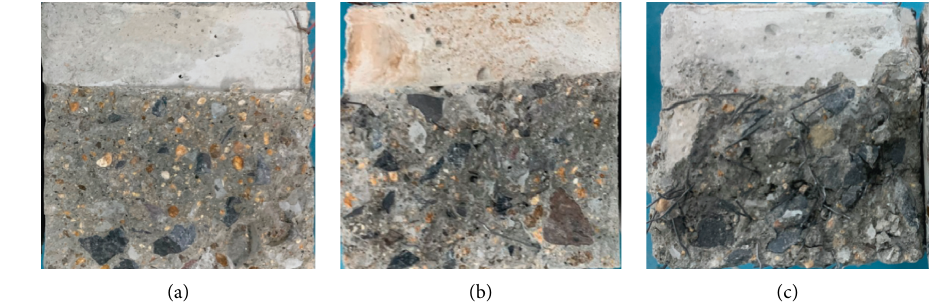
Figure 4: Fracture surface. (a) R100-1-0. (b) R100-1-0.75. (c)